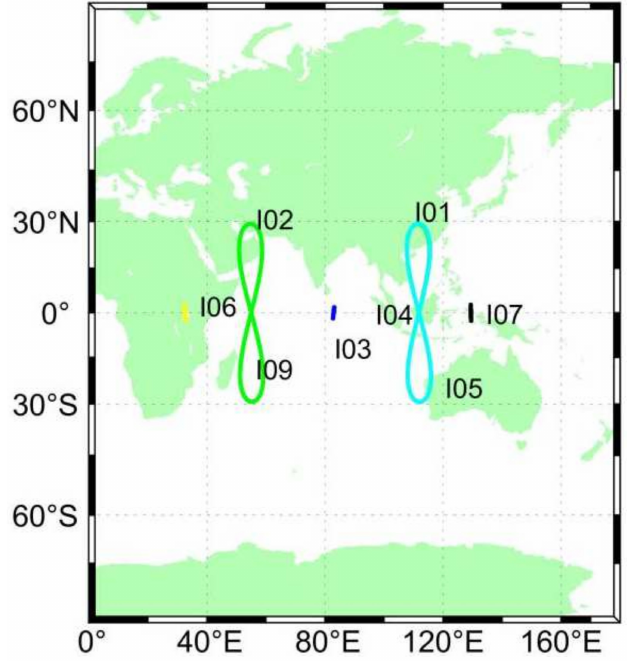
Figure 1. Ground tracks of eight IRNSS satellites on 13 July 2019.